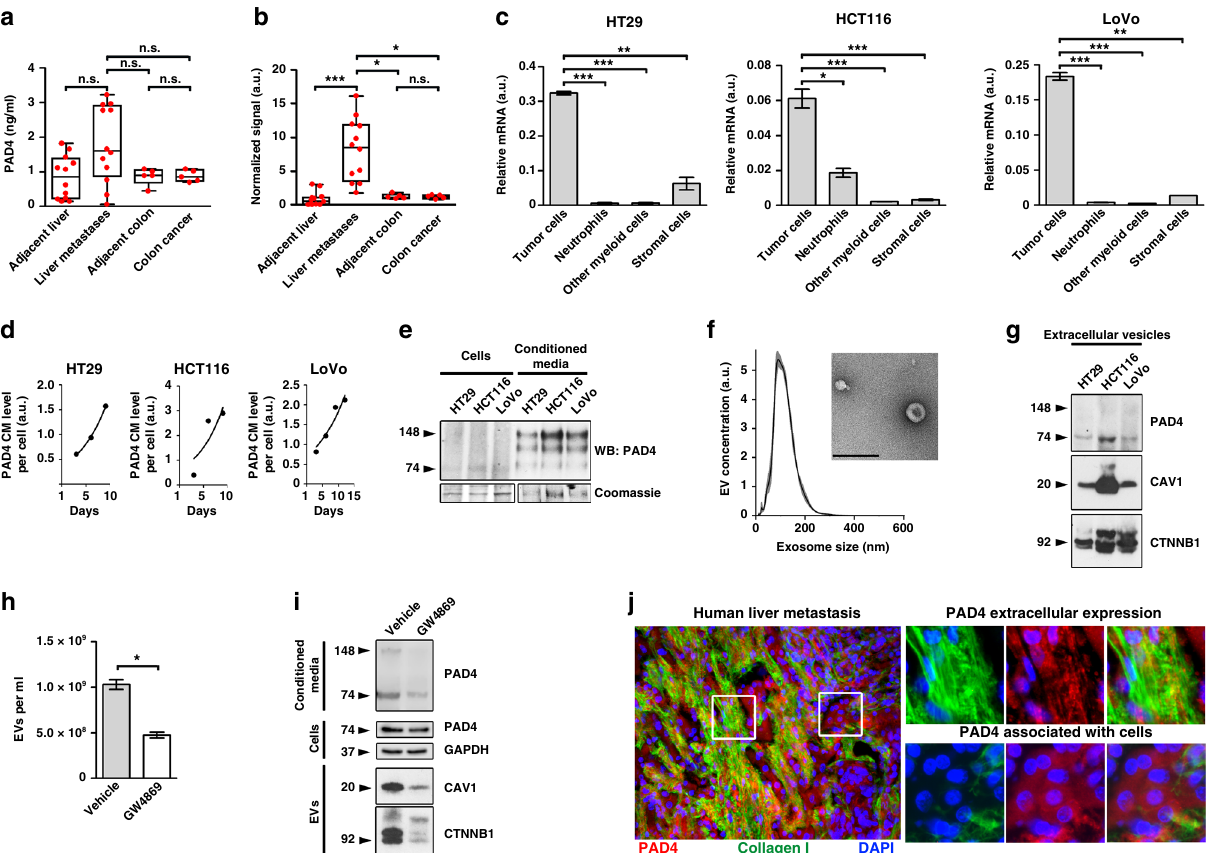
Fig. 3 PAD4 is produced by CRC cells and is contained in EVs. a ELISA for PAD4 was performed on tissue lysates extracted from human CRC hepatic metastases, paired adjacent liver tissues ( n = 12 per group), human CRC lesions and paired adjacent colon tissues ( n = 5 per group). b Densitometric analysis of immunoblotting for PAD4 performed on tissue lysates of human with CRC hepatic metastases and paired adjacent unaffected liver tissues ( n = 12) and human primary CRC lesions and paired adjacent unaffected colon tissues ( n = 5). For the densitometry, the most expressed 148 kDa dimer band was measured. Densitometry was normalized to loading control. c Relative (to HPRT) mRNA levels of PAD4 in CRC cells, granulocytes, other myeloid cells and the stromal cells isolated from CRC experimental hepatic metastases ( n = 2 biological replicates per group). d ELISA for PAD4 was performed on the conditioned media collected from cultured CRC cells at the indicated time points and normalized to the total cell number. e Immunoblotting for PAD4 was performed on HT29, HCT116 and LoVo cells and their corresponding conditioned media 6 days post-seeding. Coomassie stain was used as a loading control. f Nanoparticle tracking analysis of particle size distribution (graph) and electron microscopy (image) of EVs isolated from HT29 cells. Scale bar = 250 nm. g Immunoblotting for indicated proteins in EVs isolated from CRC cells. Representative of two experiments. h Nanoparticle tracking analysis of particle concentration of EVs collected from HT29 cells treated with vehicle or GW4869. i Immunoblotting for indicated proteins in cells, conditioned media and EVs from cultured HT29 cells treated with vehicle or GW4869. j Representative images of co-immunostaining for PAD4 and collagen I in human CRC hepatic metastasis tissue. Scale bar = 100 μ m. For a and b , error bars indicate range, box bounds indicate second and third quartiles, center values indicate median, For c and h , error bars indicate s.e.m., center values indicate mean (* P < 0.05, ** P < 0.01, *** P < 0.001, n.s. = non-signi fi cant, Mann – Whitney U test for ( h ), and Kruskal – Wallis test with Dunn ’ s post-test for a – c ). EV extracellular vesicles, CM conditioned media, WB (Fig. 3h), and a corresponding decrease in PAD4 levels in the conditioned media, without altering intracellular PAD4 levels (Fig. 3i). HT29 but not HCT116 and LoVo, was unaffected by GW4869 in a WST-1 assay of cell proliferation and viability (Supplementary Fig. 8C). Hence EVs were only analyzed from HT29. Finally, immunohistochemistry of human CRC liver metastases revealed extracellular PAD4 localization. The extra- cellular PAD4 colocalized to collagens type I and IV providing additional evidence for the presence of PAD4 in the tumor ECM (Fig. 3j and Supplementary Fig. 8D). Additional PAD4 was